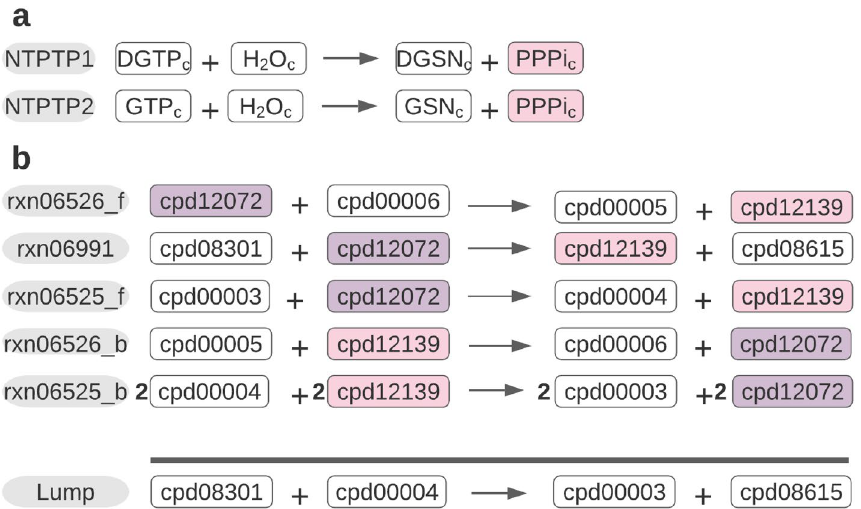
Figure 3. Real world examples of failure and success of lumping. An example for ( a ) failure taken from the iJ906 model and ( b ) success taken from the iBsu1103 model of proposed lumping procedure is shown. Colored metabolites indicate the respective missing ∆ f G 0 and hence target of lumping. Within each example the same color corresponds to the same metabolite. Bold numbers indicate a multiplicative coefficient.